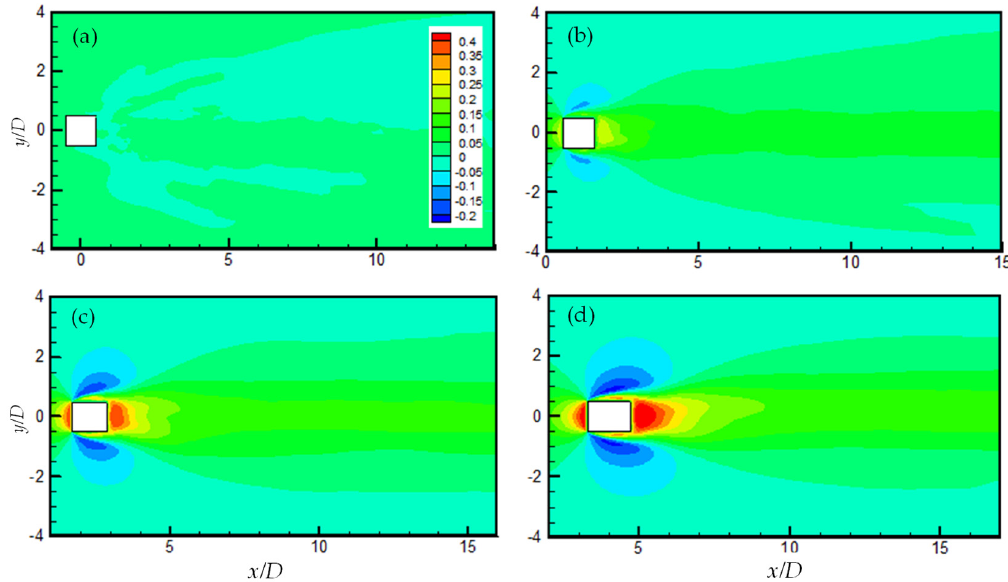
Figure 16. Contours of the time-averaged spanwise velocity w for different yaw angles viewed on the ( x , y ) plane at z = 4 D . ( a ) α = 0°; ( b ) α = 15°; ( c ) α = 30°; ( d ) α = 45°.